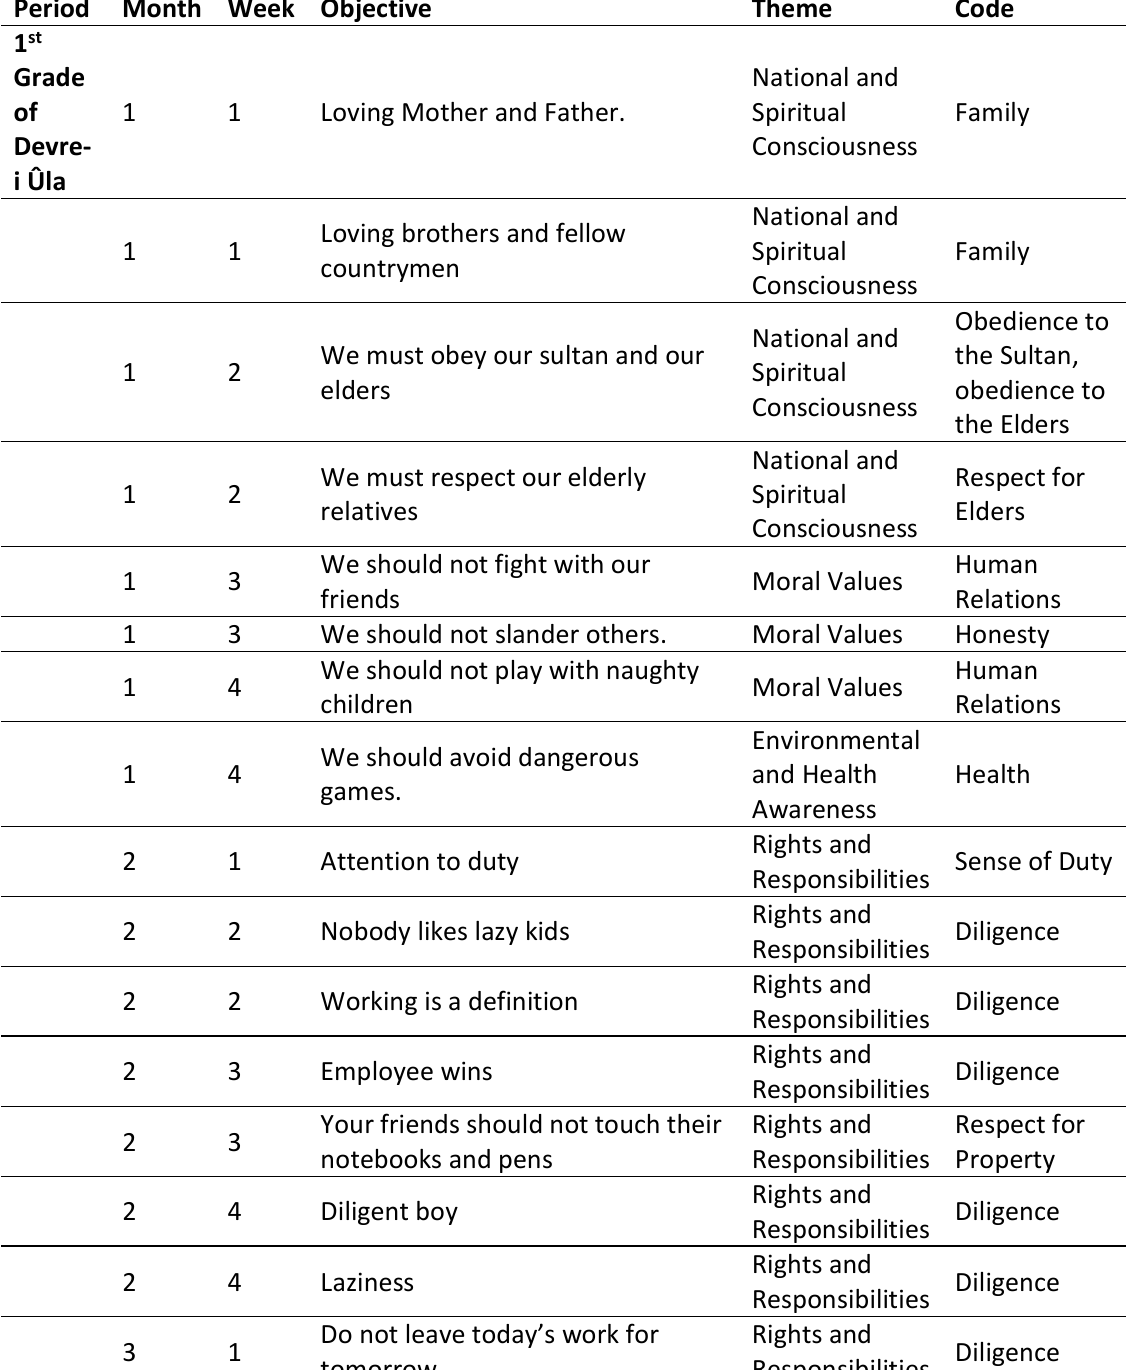
Table 1. Objectives, Themes and Values of Devre-i Ûla [First level of the primary school] 1 st